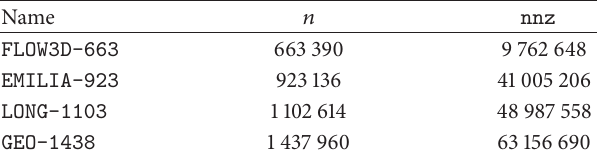
Table 1: Size 𝑛 and number of nonzeros ( nnz ) of the test matrices.